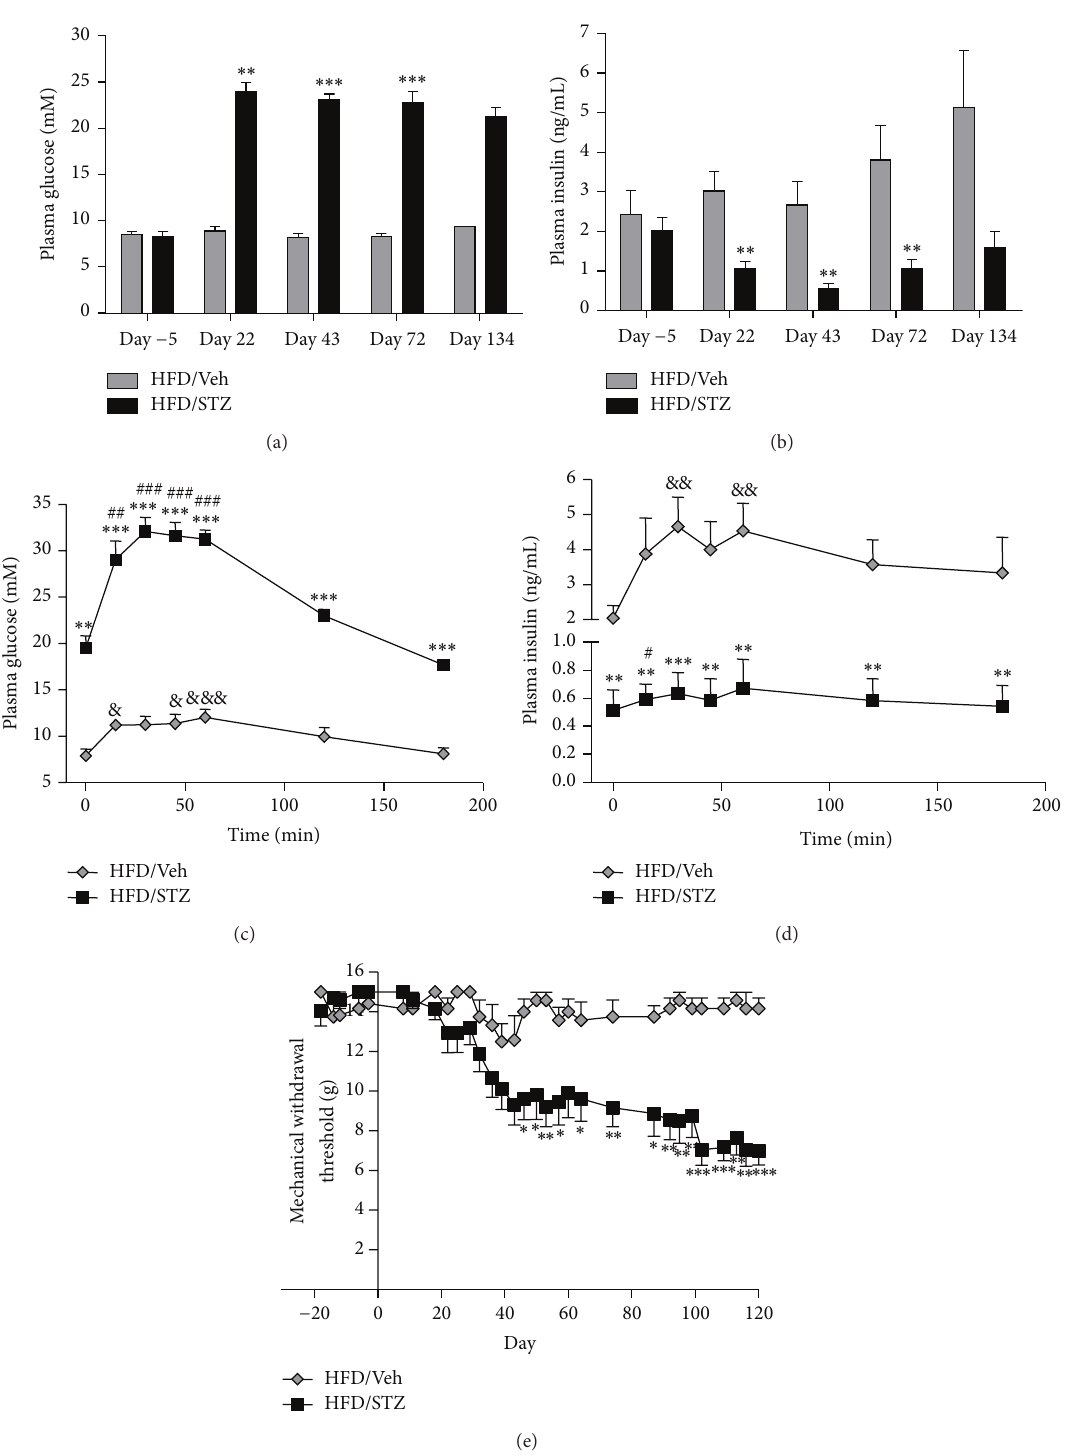
Figure 1: Effects of HFD/STZ on glucose and insulin levels, and mechanical withdrawal thresholds. Time course of the effects of HFD/STZ ( 𝑛 = 12 rats) on (a) fasting plasma glucose and (b) fasting plasma insulin, in comparison with HFD/Veh treatment ( 𝑛 = 6 rats). At day 120 an oral glucose tolerance test (OGTT) was performed and plasma glucose (c) and plasma insulin (d) were quantified in the two groups of rats. (e) Mechanical withdrawal threshold of the hindpaws was measured twice weekly for up to 120 days. Data are mean ± SEM. Comparisons between HFD/STZ and HFD/Veh rats were performed with a Mann-Whitney test: ∗ 𝑃 < 0.05 , ∗∗ 𝑃 < 0.01 , and ∗∗∗ 𝑃 < 0.001 . For further analysis of the OGTT, comparisons to baseline values in each group were made using a Friedman test with Dunn’s post hoc test: HFD/Veh & 𝑃 < 0.05 , && 𝑃 < 0.01 , and &&& 𝑃 < 0.001 ; HFD/STZ # 𝑃 < 0.05 , ## 𝑃 < 0.01 , and ### 𝑃 < 0.001